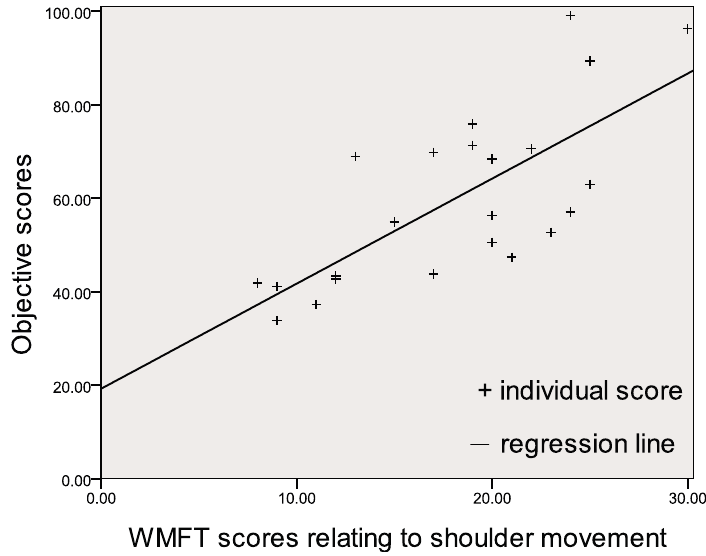
Figure 5. Linear regression between objective scores and WMFT scores relating to shoulder